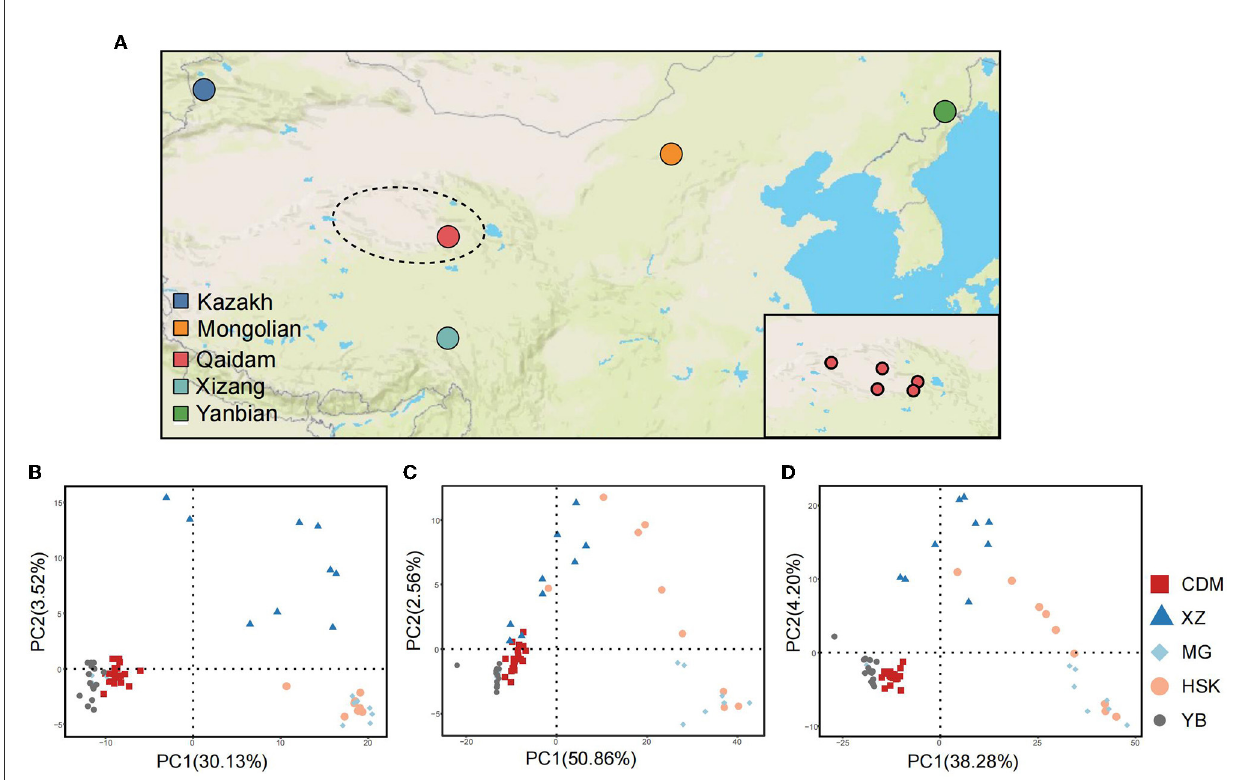
FIGURE2 Geographic distribution and population stratification in five Chinese cattle. (A) The major geographical locations of the five Chinese cattle breeds. The dotted circle represents the Qaidam Basin, which is the main geographical distribution area of Qaidam cattle. In this study, Qaidam cattle were selected from five geographical locations along the Qaidam Basin, as shown in the lower right corner, which are Dulan, Golmud, Mangya, Wulan, and Dachaidan. (B) The principal component analysis (PCA) was derived from CNVRs (deletions). (C) PCA derived from CNVRs (duplications). (D) PCA derived from all CNVRs in five population